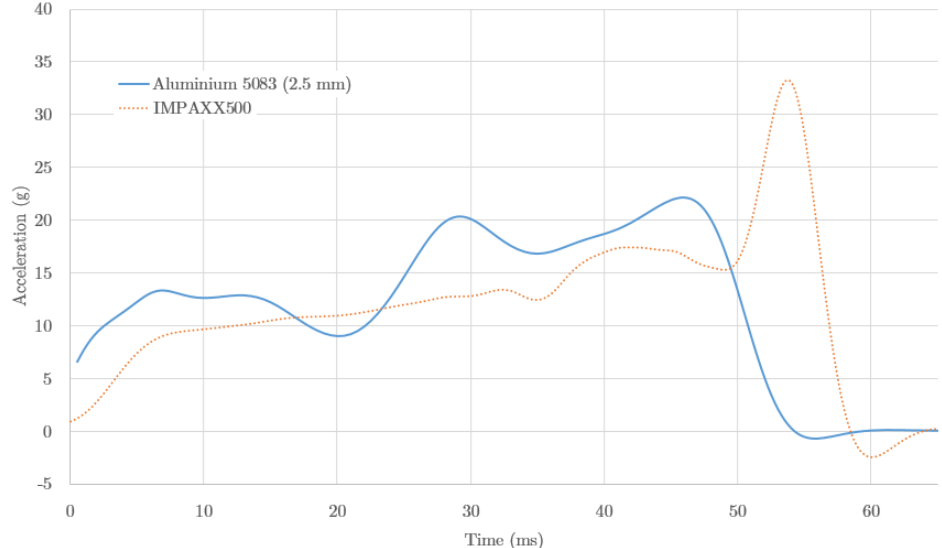
Figure 9. Results of the finite element (FE) analysis for the case materials. Acceleration (g) as a function of the time (ms) during the impact. The data corresponds to aluminium 5083-O (solid line) and the thermoplastic foam IMPAX500 (dotted